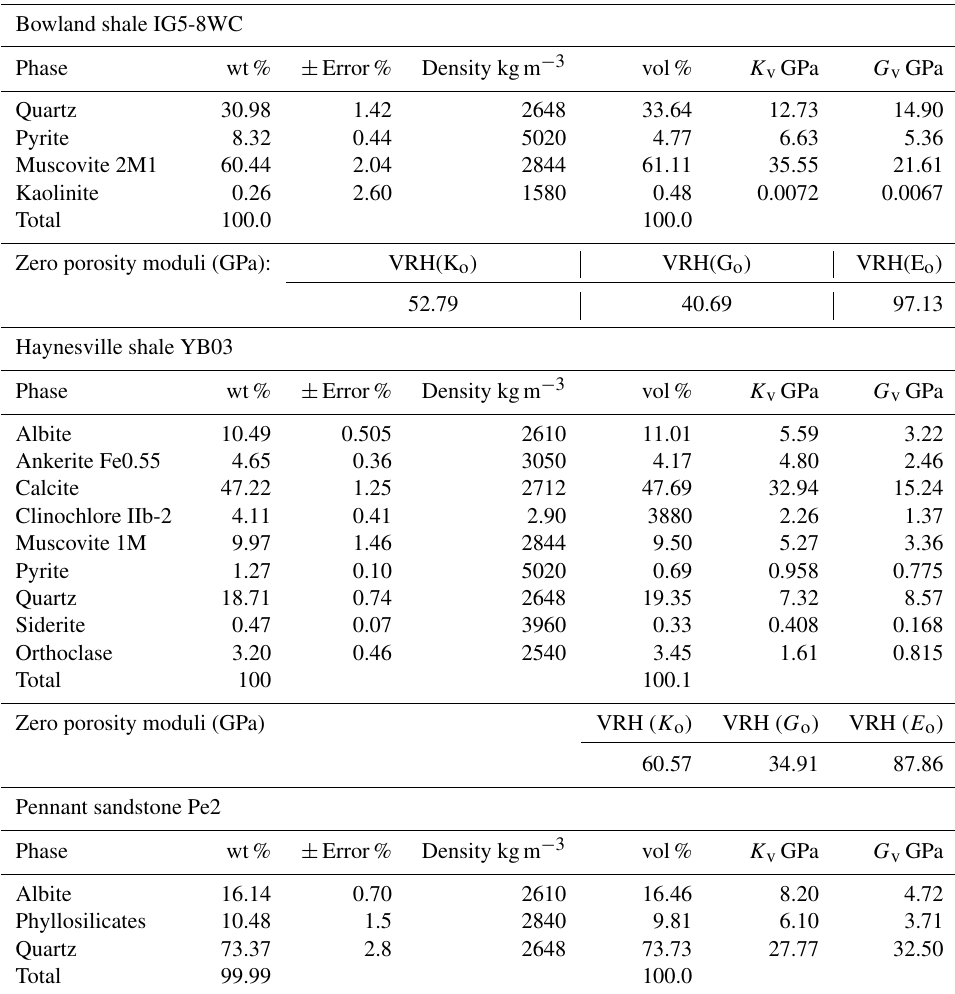
Table 1. Phase fractions, mineral densities, and Voigt-averaged bulk and shear moduli K v and G v (from literature) and calculated zero porosity elastic moduli as Voigt–Reuss–Hill (VRH) averages (GPa) for Bowland and Haynesville shales and for Pennant sandstone. Organic fraction not included. Mineral phase Reuss-average elastic moduli can be calculated from the other values supplied. K 0 = bulk modulus; G 0 = shear modulus; E 0 = Young’s modulus (VRH-averaged whole-rock values assuming isotropy). Modal volume percent is the percentage of the